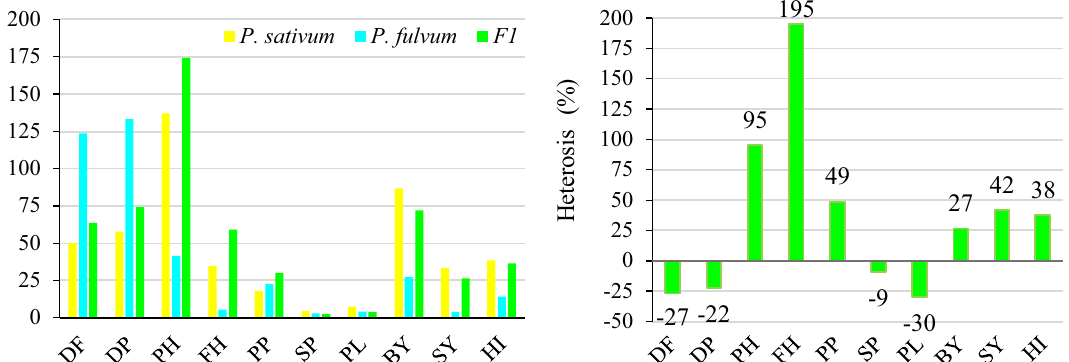
Figure 2. Comparison of agro-morphological traits in F 1 derived from interspecific crosses P. sativum × P. fulvum and their parents (left) and heterosis values (%) of F 1 plants (right). (DF is days to flowering, DP is days to pod setting, PH is plant height, FH is first pod height, PP is number of pods per plant, SP is number of seeds per plant, PL is pod length, BY is biological yield, SY is seed yield, HI is harvest index).